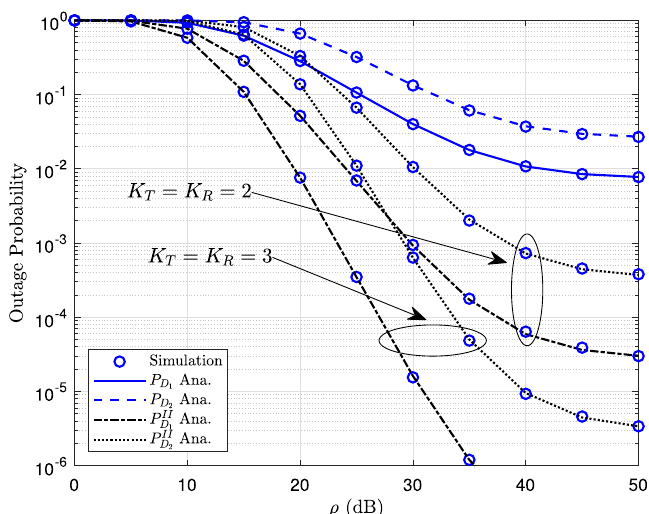
Fig. 3 Outage performance vs ρ (dB) varying K T = K R with the satellite link under HS